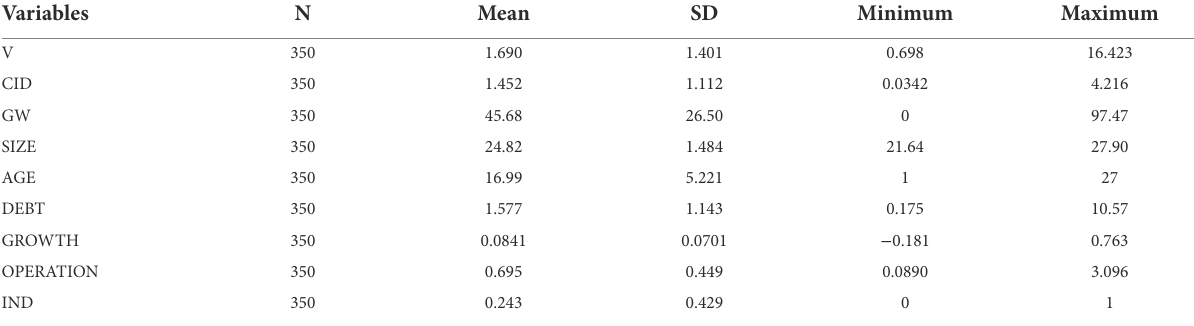
TABLE 9 Descriptive